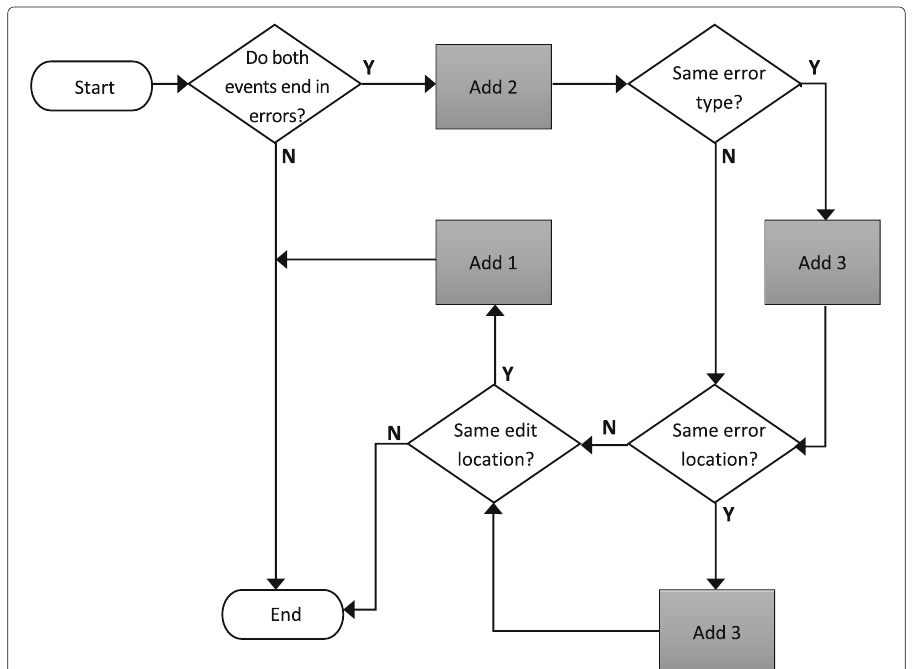
Fig. 1 The Error Quotient algorithm flowchart